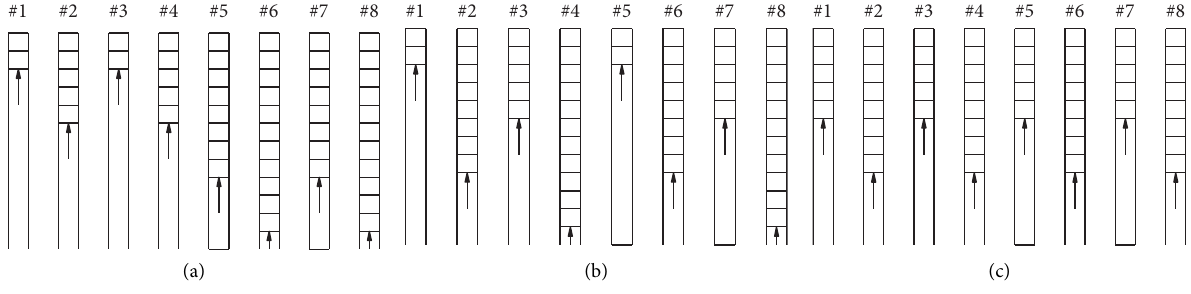
Figure 3: Schedule of 3 IESs for 8 tunnels: (a) IES1, (b) IES2, and (c)